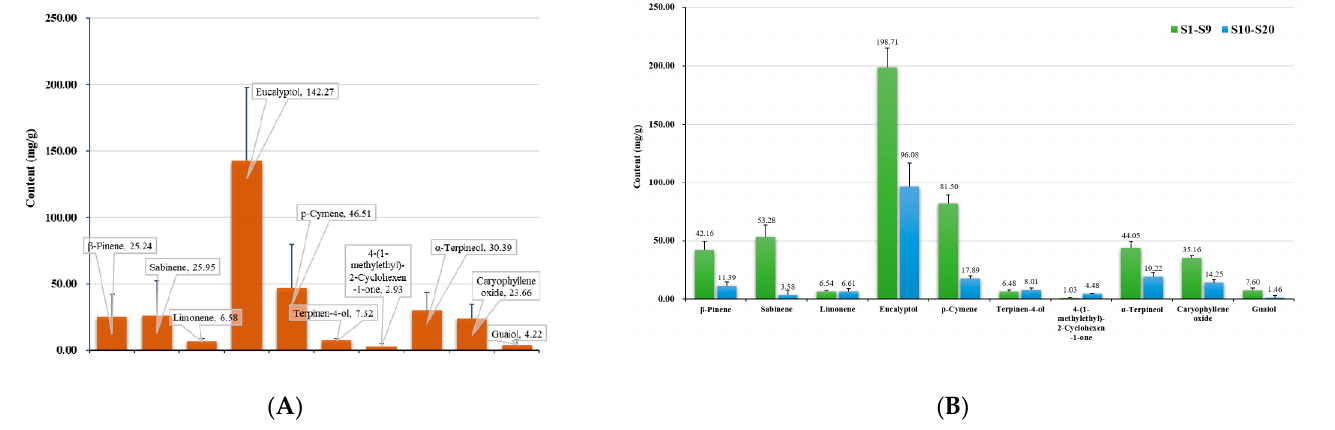
Figure 6. Average contents of 10 ingredients in 20 batches ( A ), and average contents of the 10 in- gredients in S1–S9 and S10–S20 ( B ).